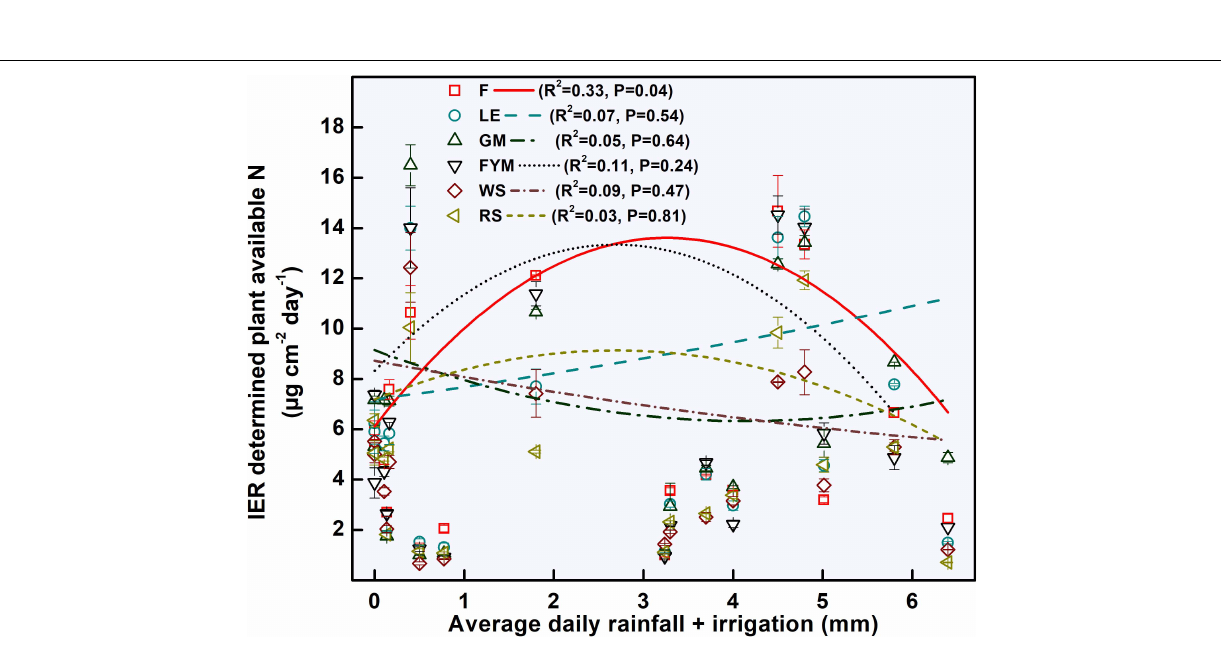
Frontiers in Plant Science |